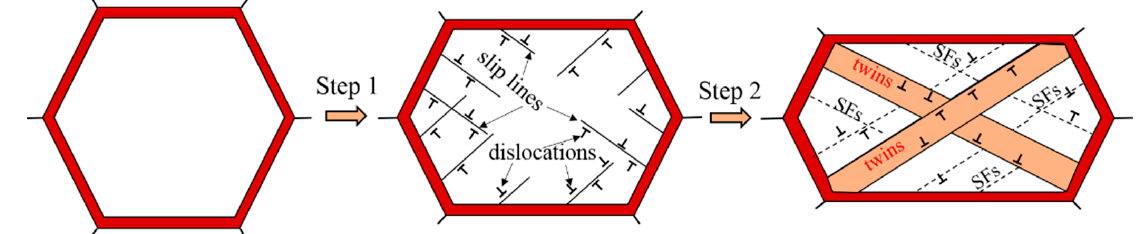
Figure 13. Schematic diagram of the evolution of the deformation marks during the medium-temperature compressive deformation of the semi-solid CuSn10P1 alloy.